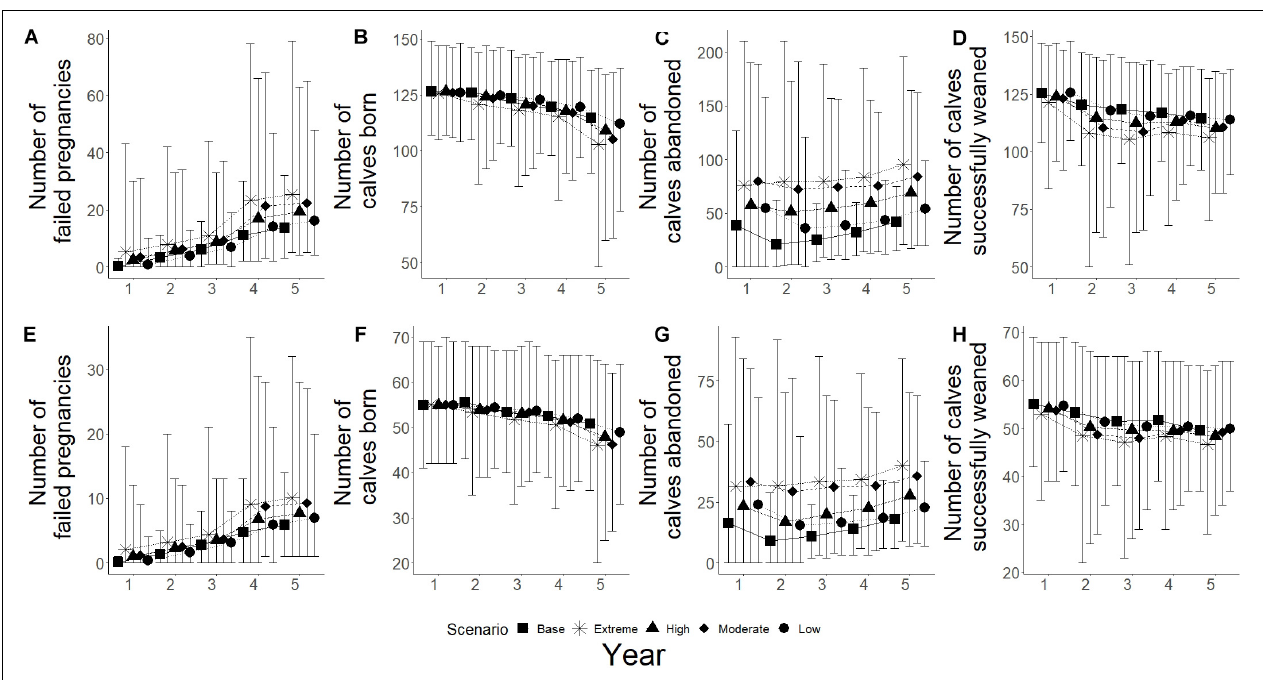
FIGURE 7 | Reproductive parameters under climate simulations for both populations. Five scenarios presented with base ( (cid:4) ), extreme ( ∗ ), high ( (cid:78) ), moderate ( (cid:7) ), and low (